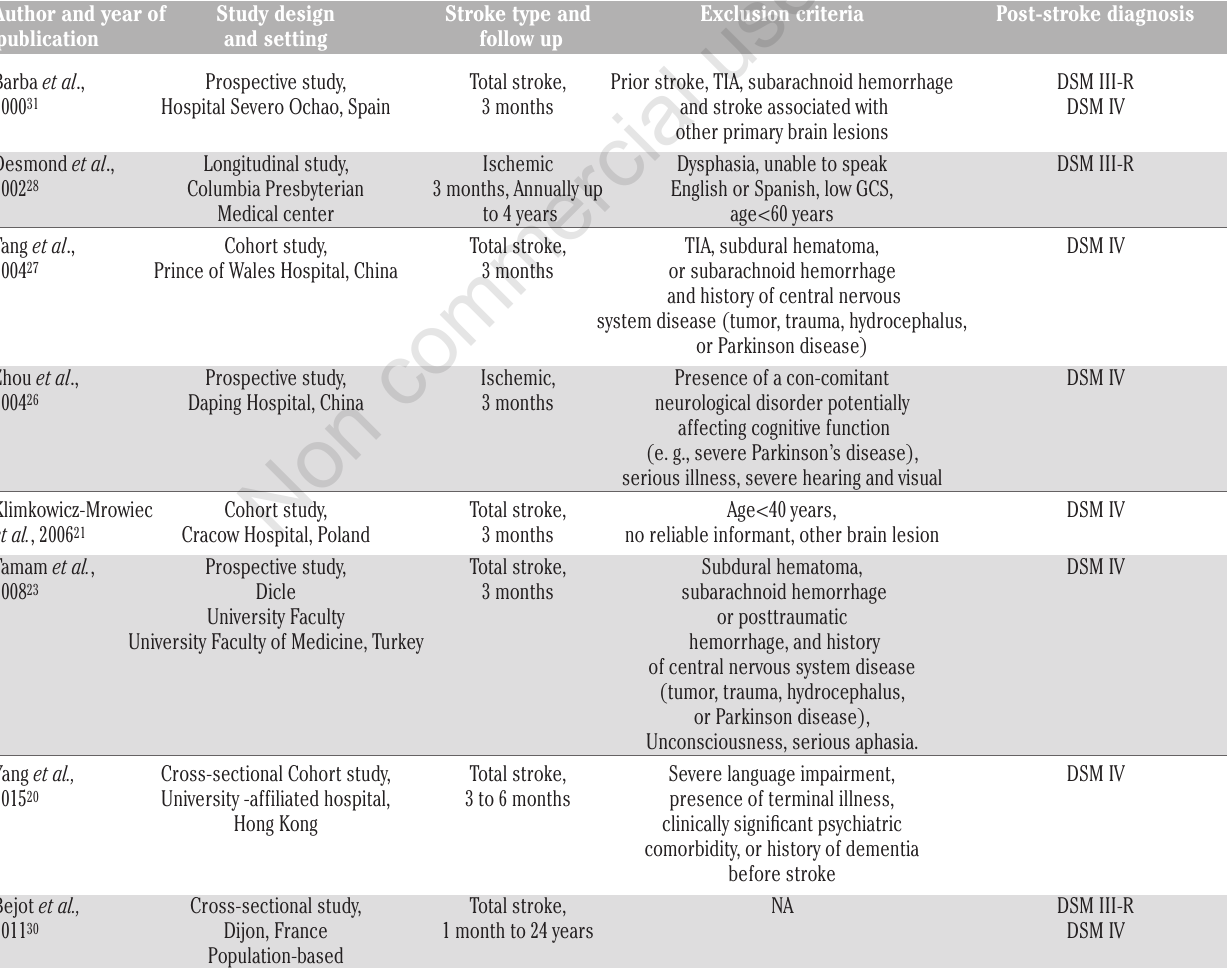
Table 1. Demographic detail of hospital-based and population-based studies of dementia after